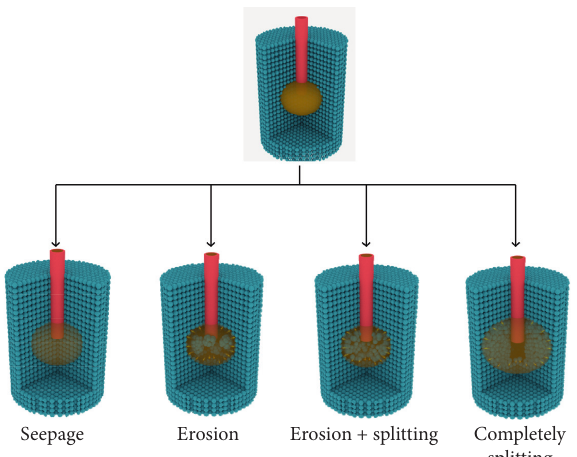
Figure 15: Mechanisms of interaction between grouting and soil (the red round pipe represents the grouting pipe; blue spheres represent soil particles; yellow arrows indicate that grout impinges on soil particles under grouting pressure).